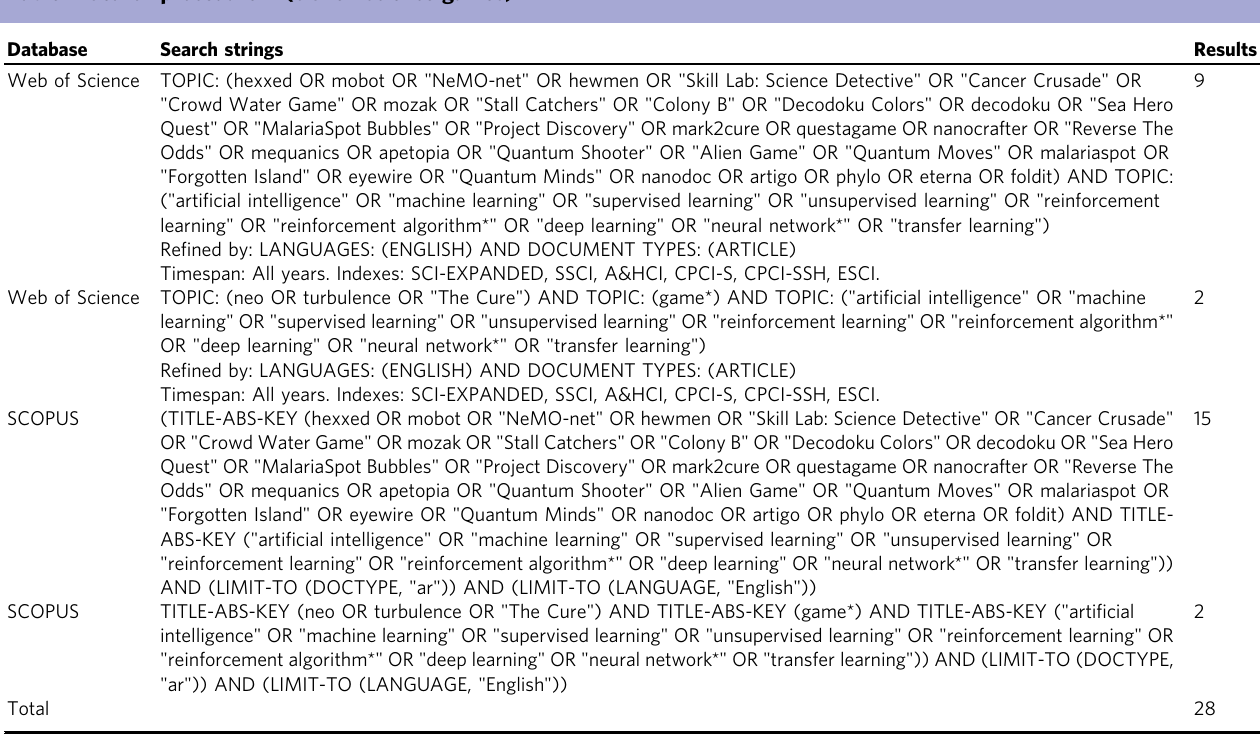
Table 2 Search procedure 2 (citizen science games). Database